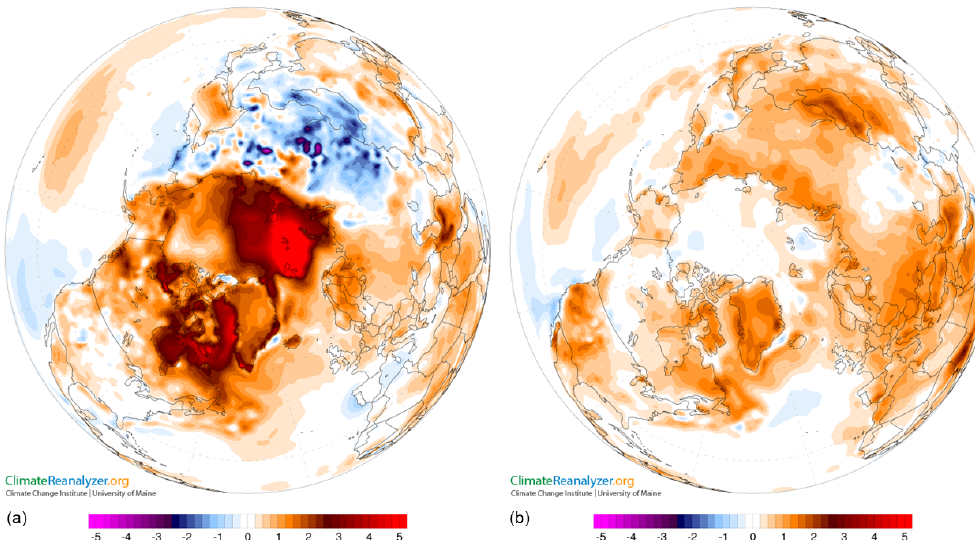
Figure 1. Differences in winter (DJF, a ) and summer (JJA, b ) 2m air temperature (in ◦ C) between the periods 2000–2015 and 1979–1999 according to ERA-Interim reanalysis. Figure drawn applying Climate